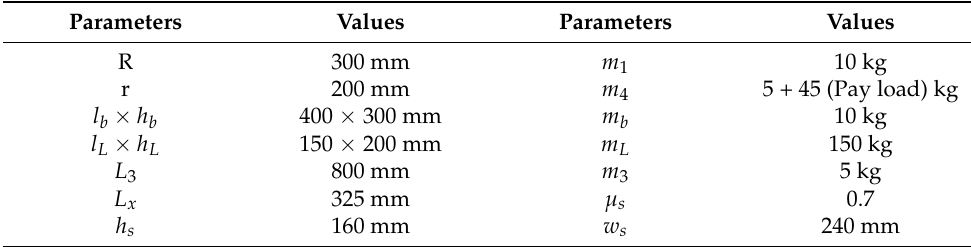
Table 2. Dimension of the robot for